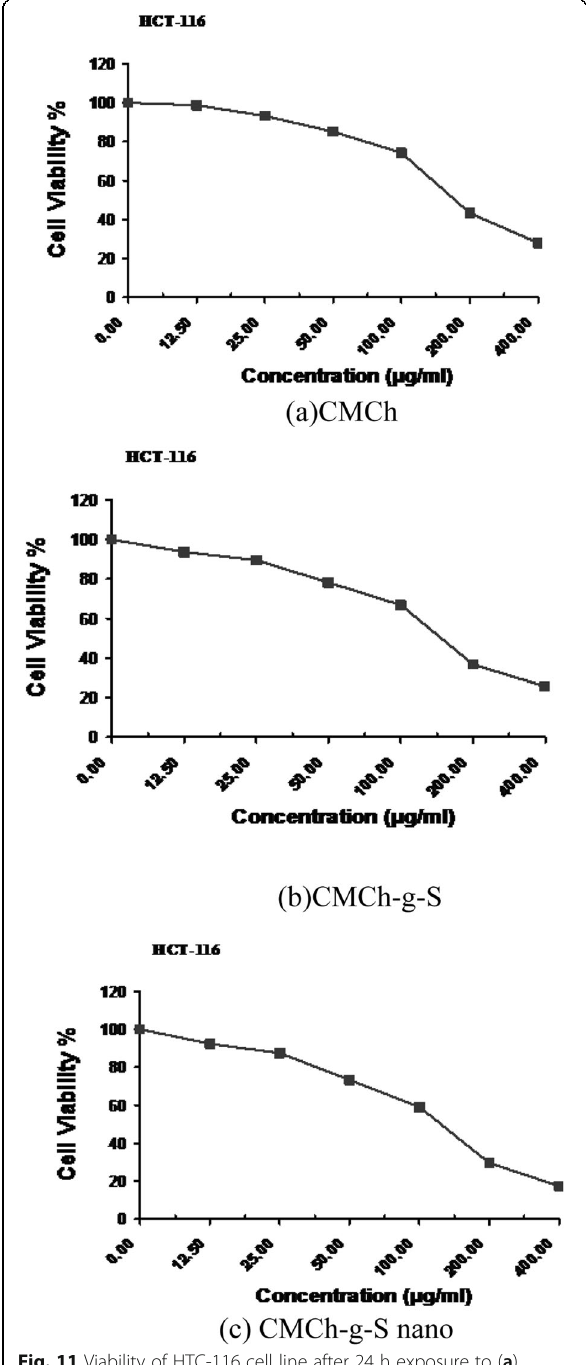
Fig. 11 Viability of HTC-116 cell line after 24 h exposure to ( a ) CMCh, ( b ) CMCh-g-S and ( c ) CMCh-g-S